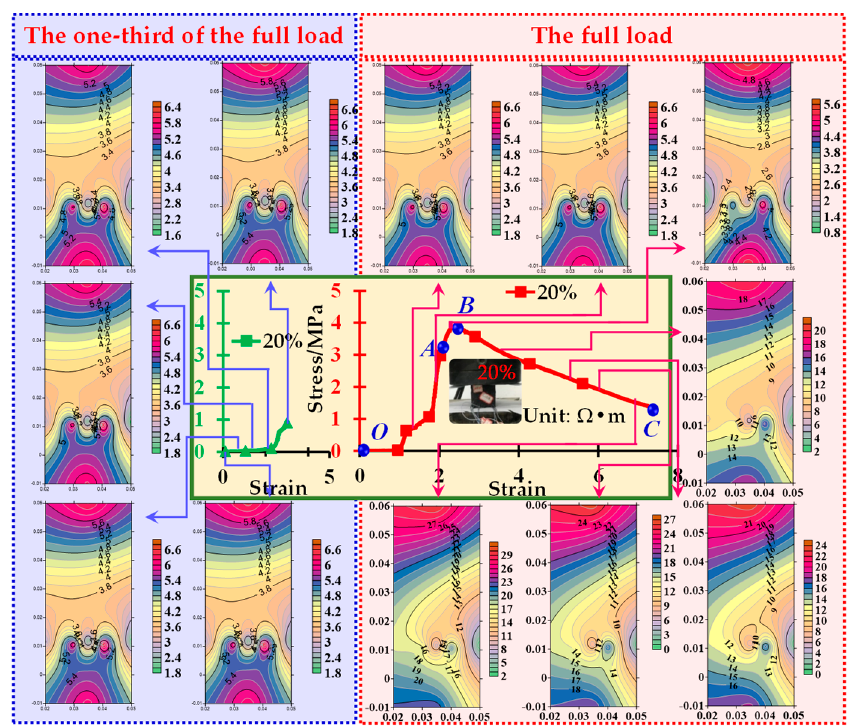
Figure 15. Variation cloud charts of the specimen with 20% graphite at different stages in the cyclic loading process.